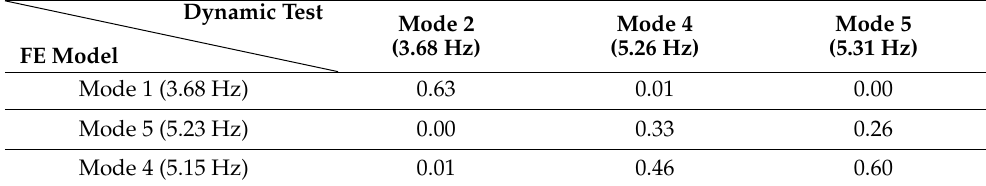
Table 7. MAC values for MODEL_1 and AVT.